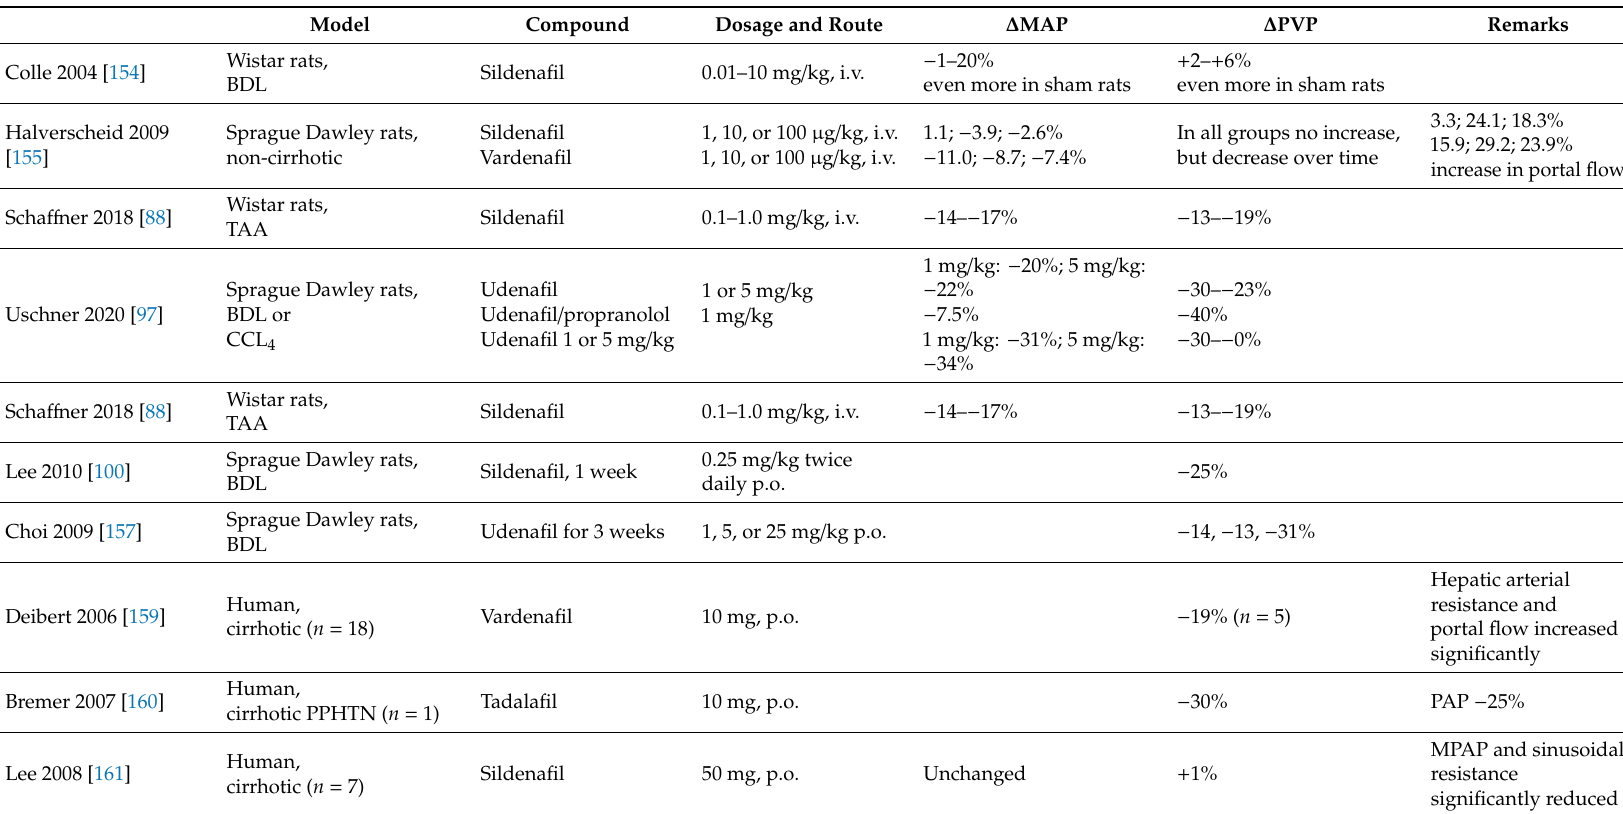
Table 1. E ff ects of PDE-5 on portal and systemic hemodynamics in animal and human